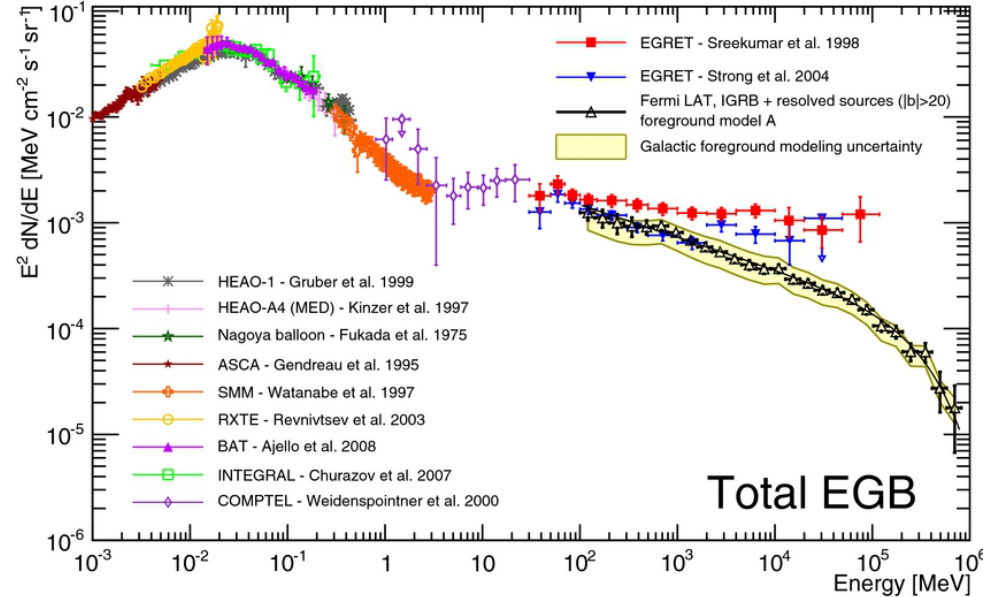
Figure 4. Cosmic X-ray, MeV Gamma-ray, and GeV Gamma-ray background radiation spectrum. Taken from Ackermann et al.